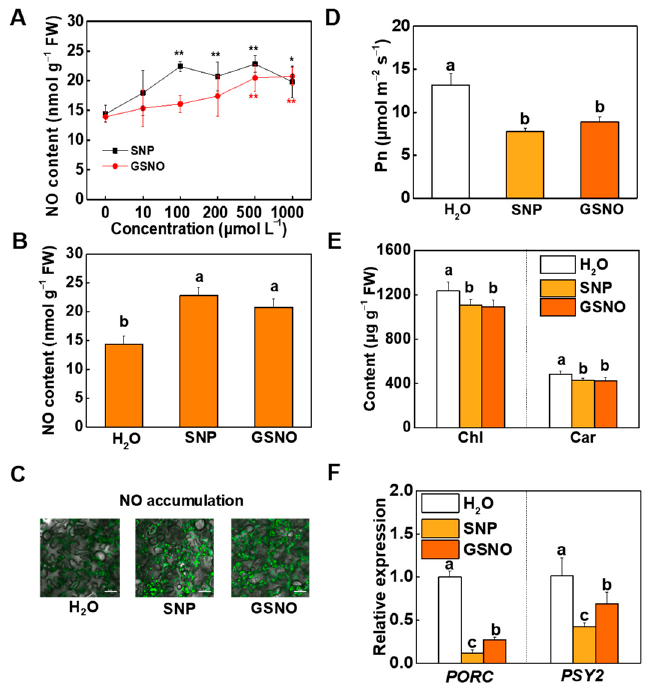
Figure 2. Exogenous NO donors regulate plant photosynthetic pigment biosynthesis. ( A ) NO levels induced by different concentration gradients of sodium nitroprusside (SNP) and S ‐ nitroso glutathione (GSNO). ( B , C ) NO accumulation, ( D ) Pn, ( E ) chlorophyll and carotenoid content of leaves, and (F) relative transcript levels of PORC and PSY2 in tomato plants treated with H 2 O, 500 µ M SNP, and 500 µ M GSNO. NO, chlorophyll and carotenoid content were assayed 5 days after being treated with H 2 O, SNP, and GSNO, while Pn was determined at 3 days after the commencement of exogenous NO treatment. For ( C ), representative images were selected from eight replicates of each treatment; horizontal bars = 20 µ m. For other determinations, data are shown as means ± SD ( n = 3). For ( A ), asterisks indicate statistically significant differences from the control (0 μ M SNP or GSNO) with respect to the means (**, p < 0.01; *, p < 0.05). For ( B ) and ( E , F ), different letters indicate significant differences at p < 0.05 according to Tukey’s test.